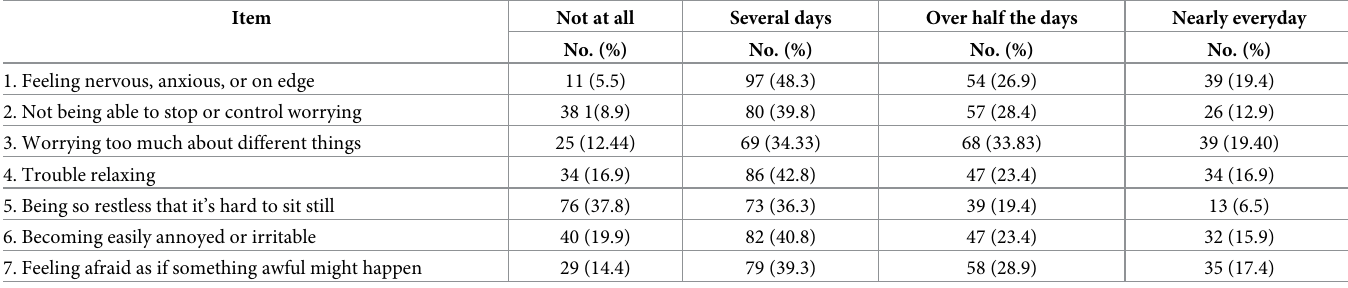
Table 5. Participants’ response to the generalized anxiety disorder